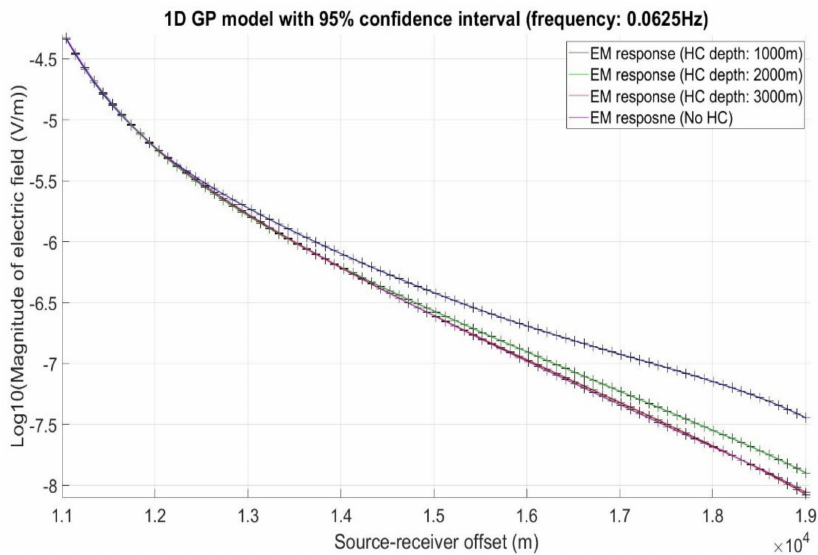
Figure 10. 1D GP models of MVO responses observed along the receiver line from four di ff erent SBL models at a frequency of 0.0625 Hz: (i) model with hydrocarbon depth of 1000 m (blue); (ii) model with hydrocarbon depth of 2000 m (green); (iii) model with hydrocarbon depth of 3000 m (red); (iv) model with no hydrocarbon layer